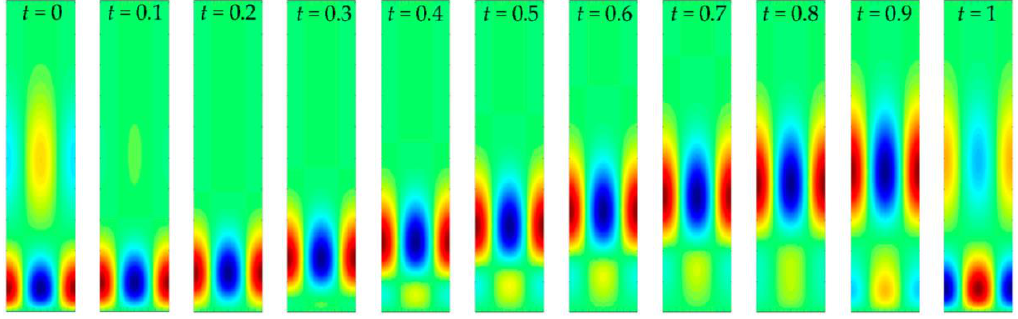
Table 2. The dependence of the critical wavenumber and Rayleigh number on the numerical method and the timestep.